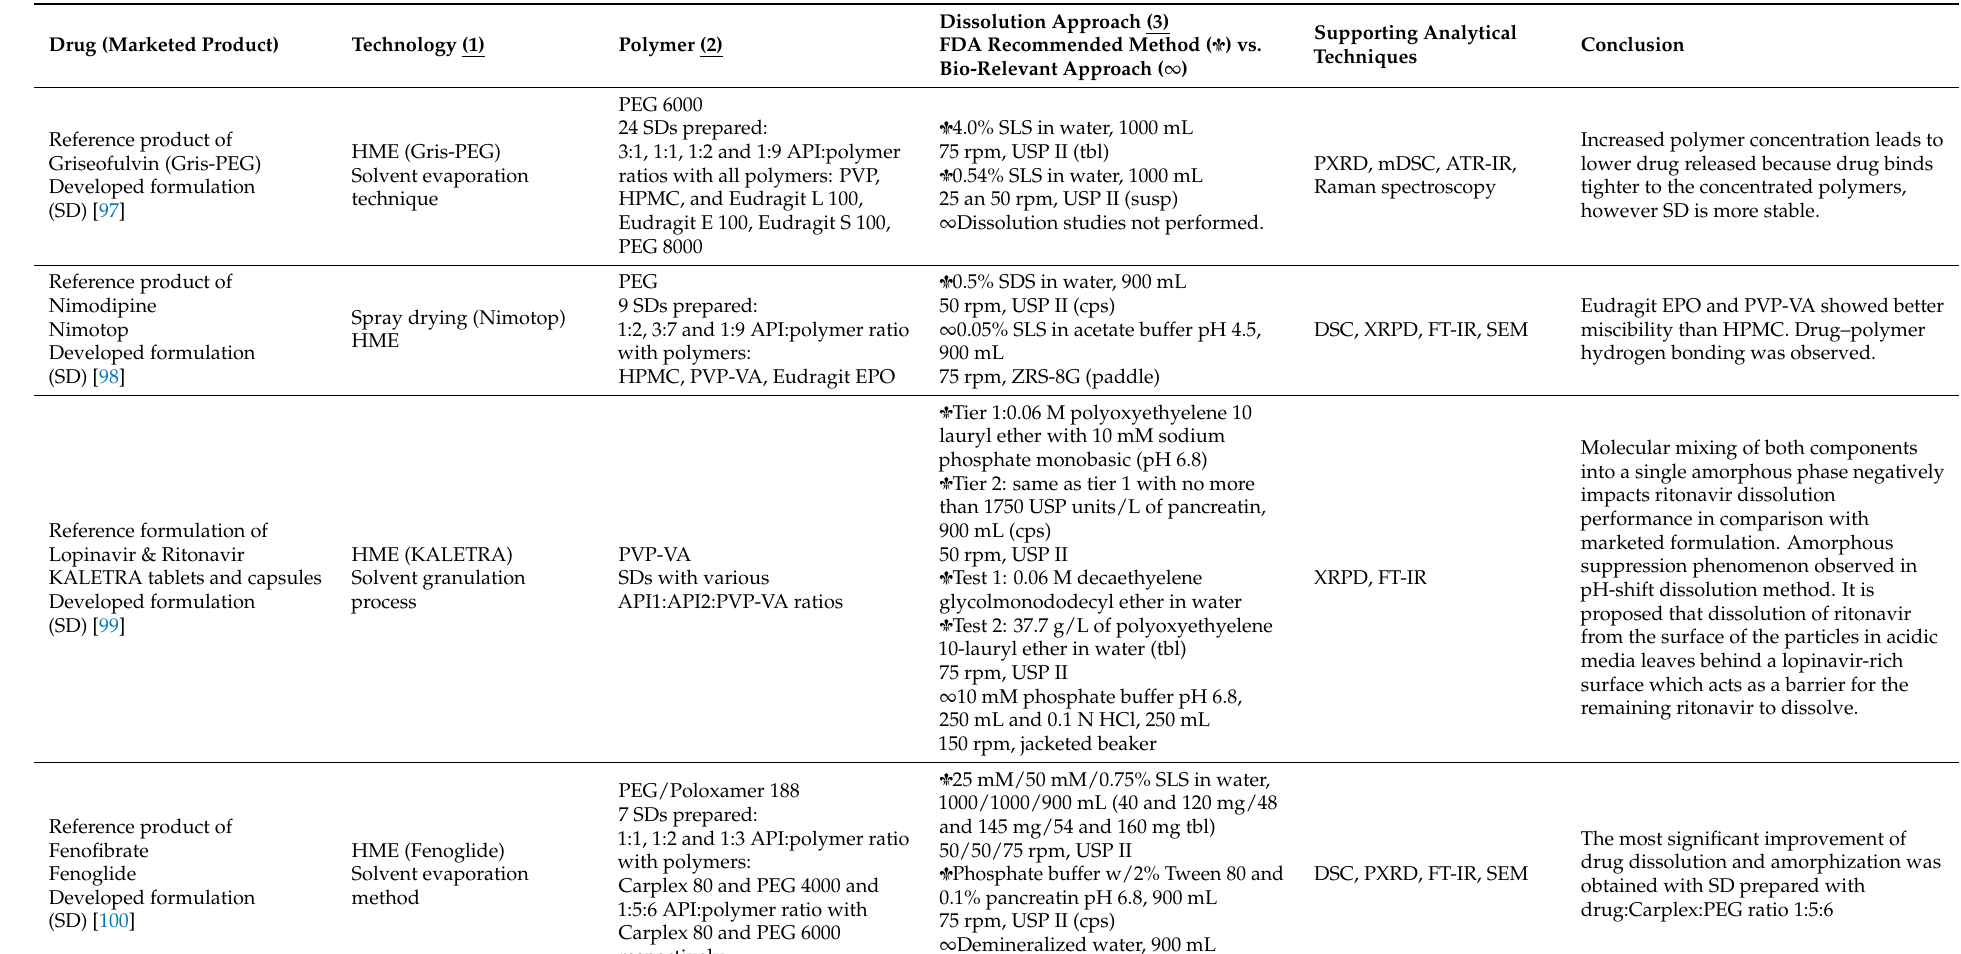
Table 2. Review of dissolution studies on amorphous solid dispersion formulations.